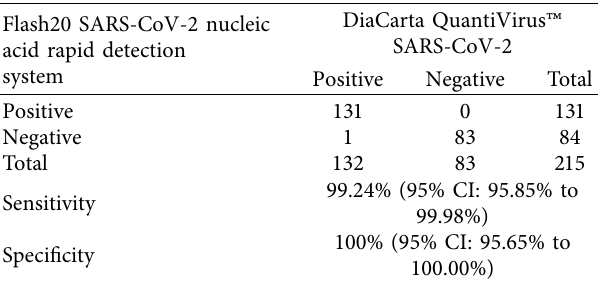
Table 6: Test results compared to DiaCarta QuantiVirus ™